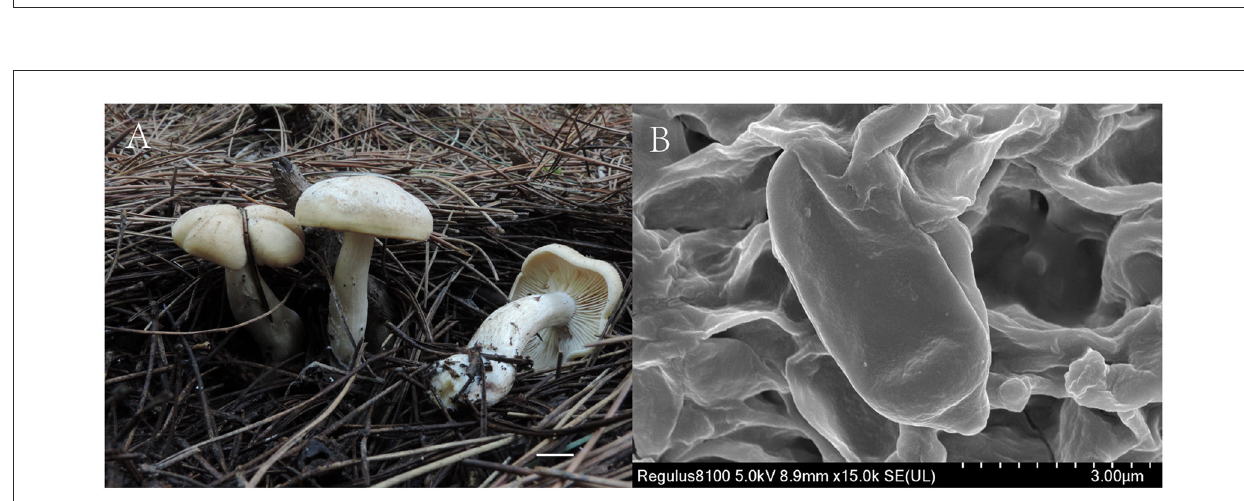
FIGURE4 Gerhardtia tomentosa (Holotype, SYAU-FUNGI-074). (A) macroscopic habitat (B) surface of basidiospores. Scale bars: 1cm (A) ; 3 µ m (B)